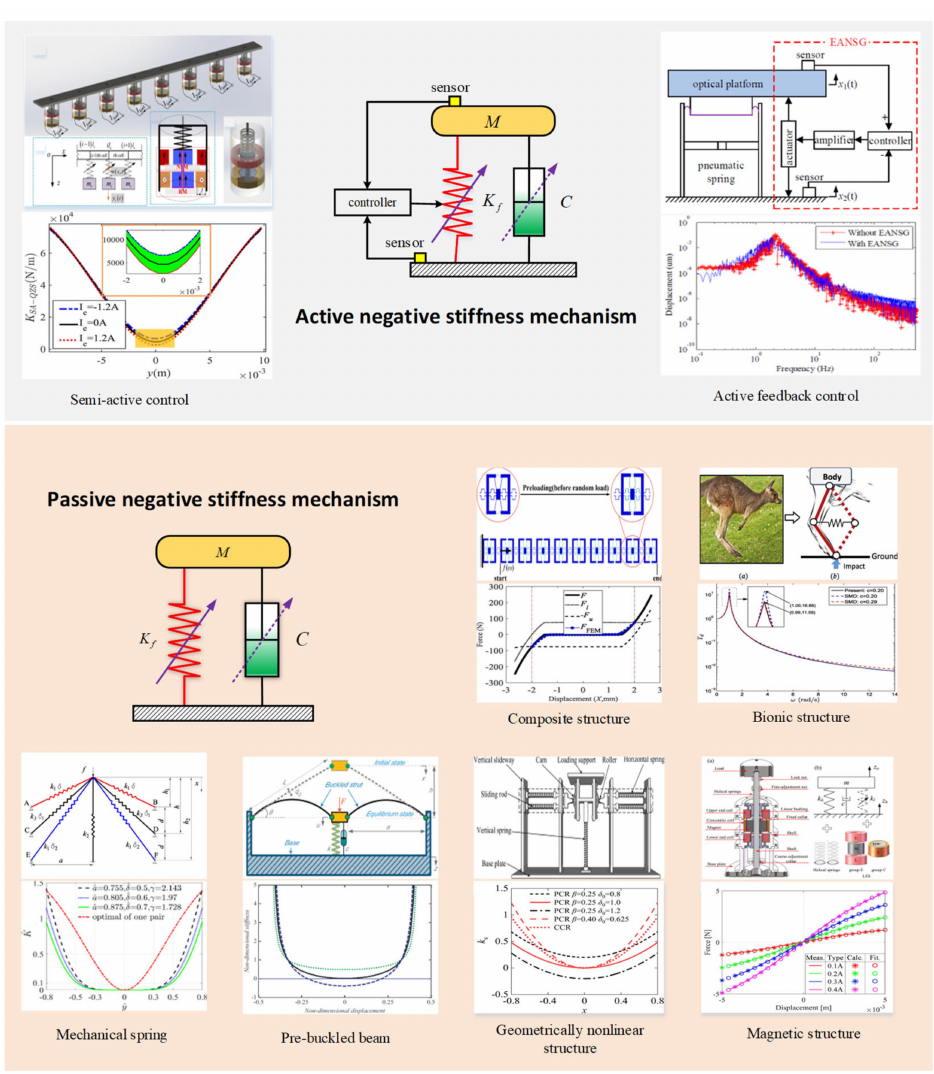
Figure 6. Overview of QZS vibration isolation systems: realization methods and characteristic differences. Wang and Zhao et al. [127,131] proposed a vibration isolator with active negative-stiffness mechanism. Figures adapted with permission from Ref. [127]. Copyright 2020, copyright Wang, K. Zhao et al. [8,9], Liu et al. [36], Zuo et al. [52] Yuan [77], Dai et al. [85] and Zhou et al. [116,117] used vibration isolators with the proposed six types of passive negative-stiffness mechanisms. Figures adapted with permission from Refs. [9,36,52,77,85,116]. Copyright 2021/2013/2022/2020/2018/2020, copyright Zhao, F./Liu, X./Zuo, S./Yuan, S./Dai, H./Cai,